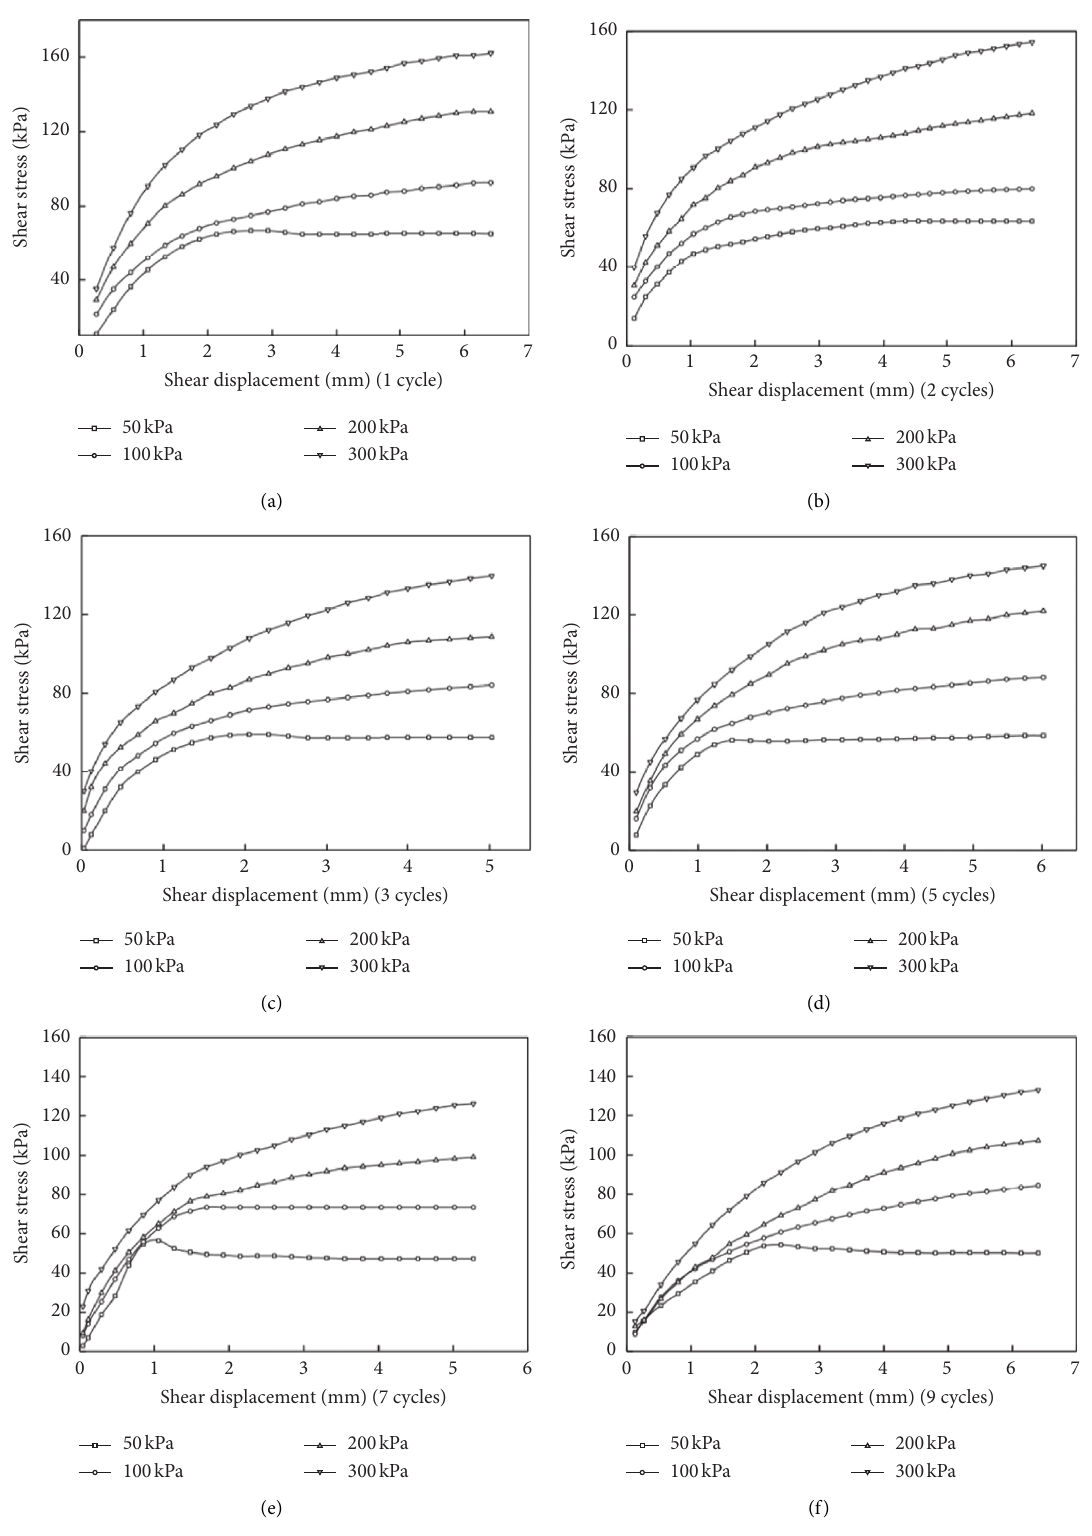
Figure 4: Straight shear test curve of red clay under different dry and wet cycles ( ρ